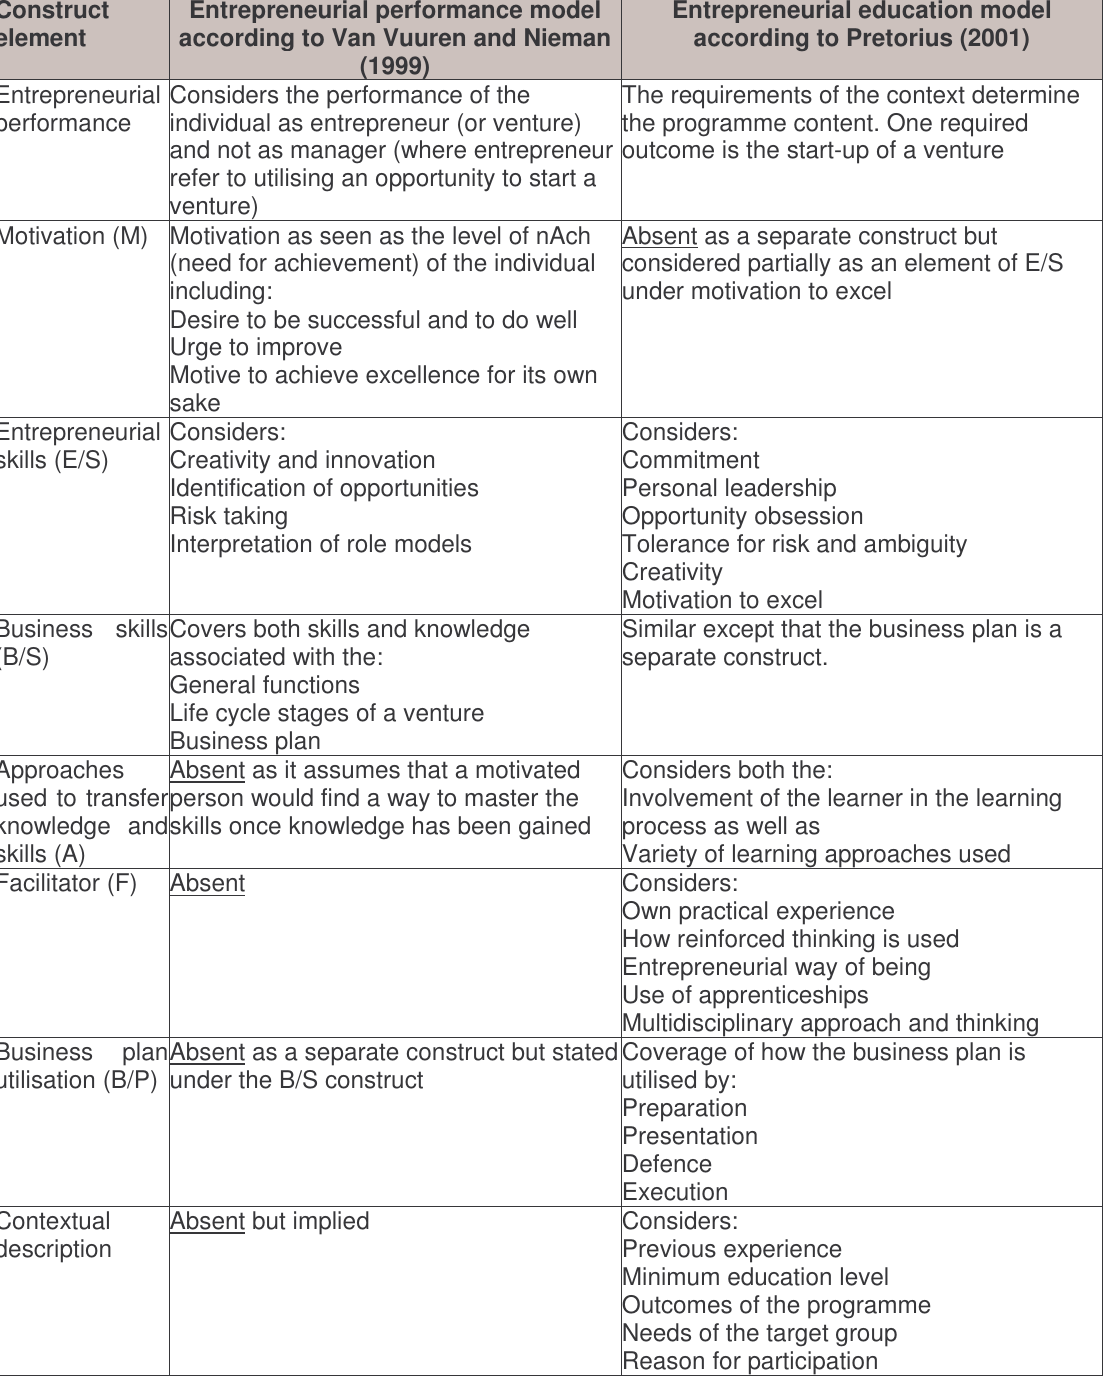
Table 1: Comparison of the education models of van Vuuren and Nieman (1999) and Pretorius